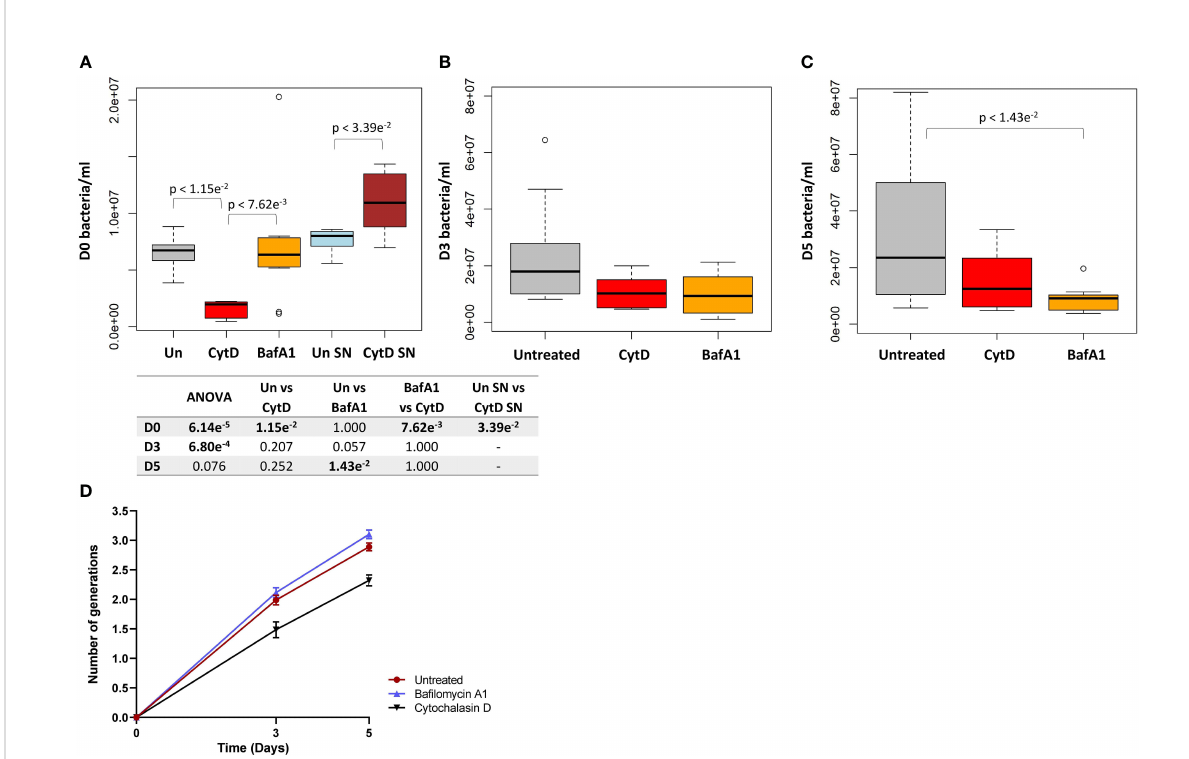
FIGURE 5 Intracellular bacterial growth following treatment with inhibitors of phagocytosis and phagosome acidi fi cation. Macrophages were either untreated or pre-treated with 6 m M CytD or 10 nM BafA1 for 40 min prior to infection with M. tuberculosis D leuD D panCD ::pTiGc pre-induced with 4 mM theophylline. (A) Following internalization, macrophages were lysed and intracellular bacteria was harvested for fl ow cytometry. A 3.42 fold decrease in the median bacterial uptake was detected following CytD treatment compared to untreated macrophages at day 0 (p = 1.15e -2 ). The supernatant following bacterial uptake displayed signi fi cantly increased bacterial numbers following CytD treatment (p = 3.39e -2 ), con fi rming inhibition of phagocytosis of M. tuberculosis D leuD D panCD ::pTiGc. Uptake of bacteria was unaffected by BafA1 treatment compared to bacterial numbers harvested from untreated macrophages (p = 1.000). The effect of the inhibitors on bacterial growth were assessed at (B) day 3 and (C) day 5 post infection. Bacterial numbers following CytD treatment remained similar to untreated macrophages at day 3 and day 5 (p-values > 0.207), whilst a signi fi cant decrease in bacterial numbers following BafA1 treatment was observed at day 5 compared to untreated macrophages (p = 1.43e -2 ). Box and whisker plots express distribution of data independently conducted in biological triplicate, including technical triplicates, indicating the median (bold line), interquartile range (box), and range (whiskers). Signi fi cance testing between groups was assessed by repeated measures ANOVA and pairwise Students t-test with Bonferroni correction; signi fi cant p-values (p < 0.05) are shown in bold. (D) The number of intracellular